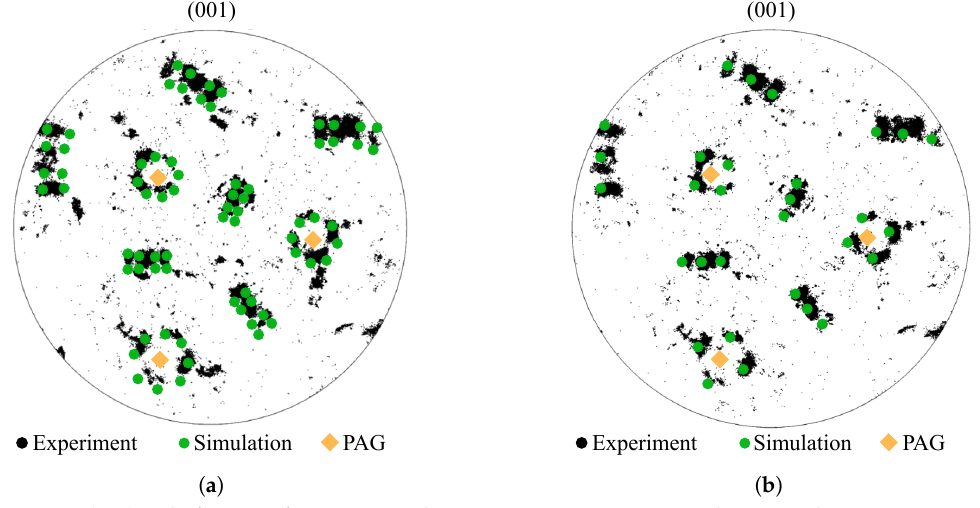
Figure 2. (001) pole figures of experimental martensitic orientations within a single prior austenite grain, corresponding simulated martensitic orientations and the underlying prior austenite grain orientation: ( a ) with simulated Kurdjumov–Sachs OR ( b ) with simulated Nishiyama–Wassermann